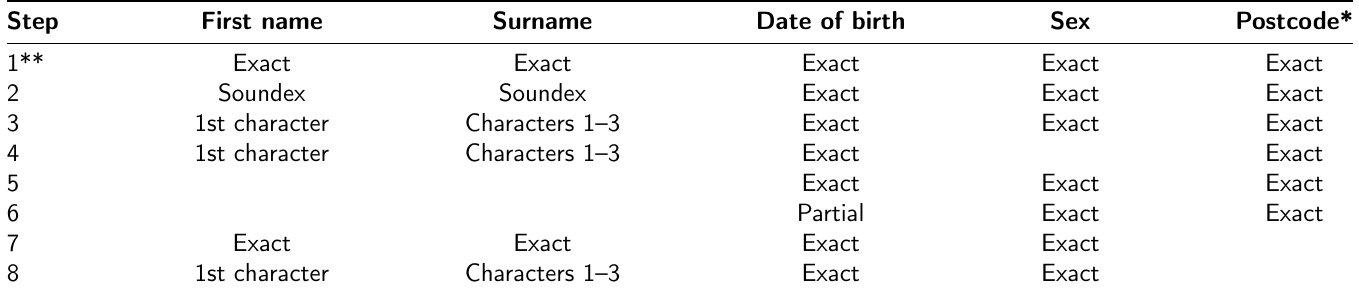
Table 2: Linkage stage 1:8 step deterministic algorithm for linking the national pupil database to the personal demographic service Step